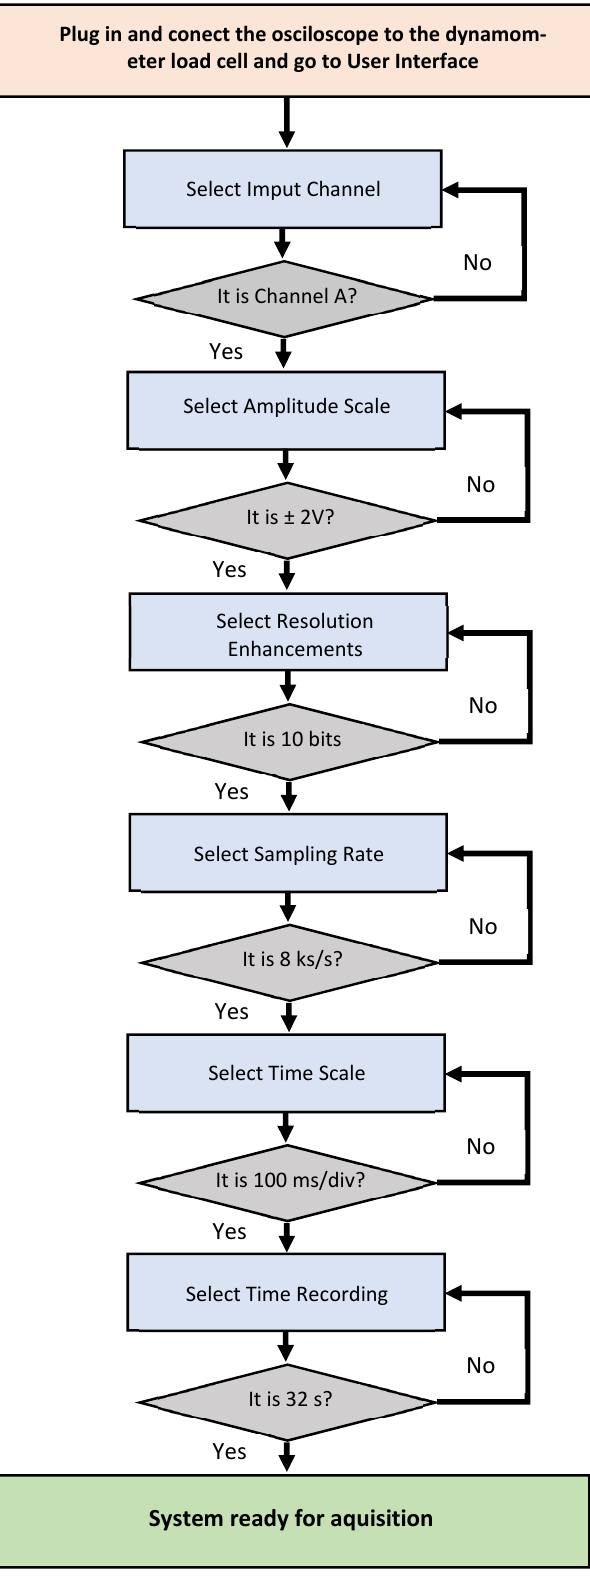
Figure 2. Flowchart for PicoScope6 parameters selection guide. Detailed graphic user interface and the selected parameters for the oscilloscope configuration: Channel A on, direct current (DC) coupling, input = 2 V and time/div = 100 ms/div (32 s length record) and 10 bits resolution enhancement.